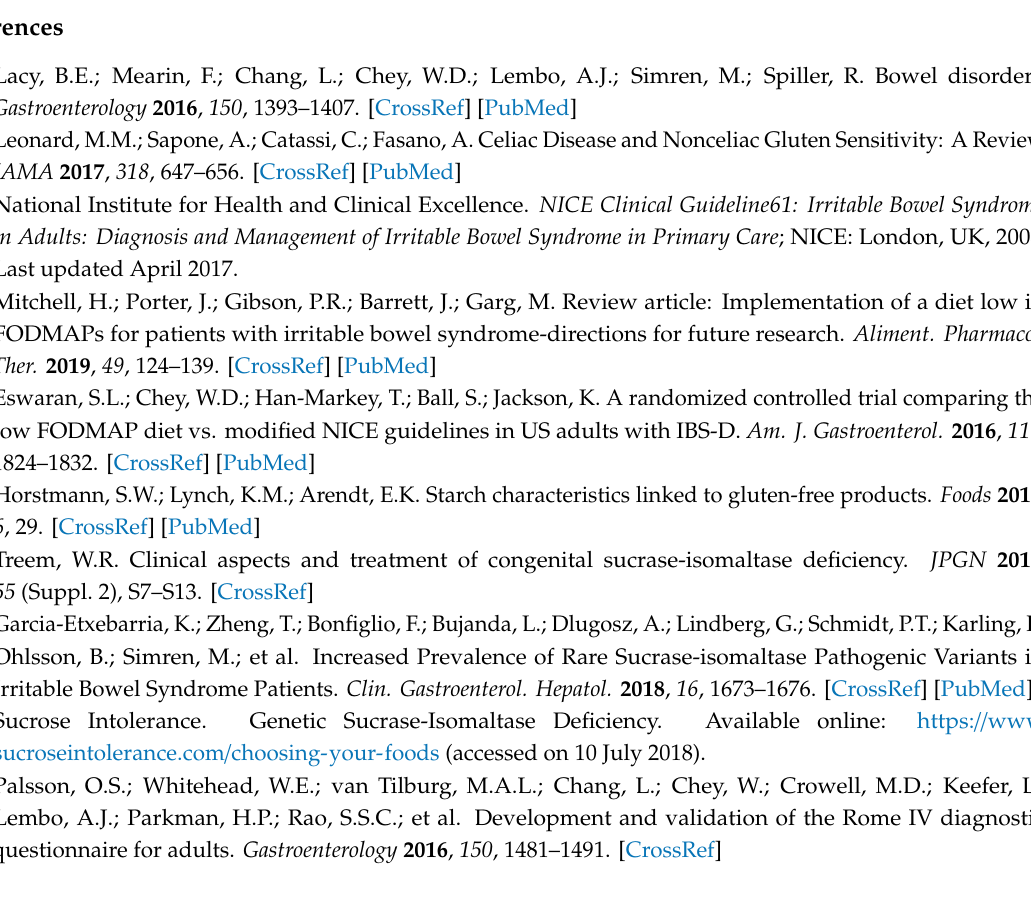
Table S1: Reasons for not being eligible for / declining study participation, Table S2: Recommendations of fruit intake according to a starch- and sucrose- reduced diet, Table S3: Recommendations of vegetable and legume intake according to a starch- and sucrose-reduced diet, Table S4. Concomitant diseases besides irritable bowel syndrome (IBS) and drugs used as regular treatments, Figure S1: CONSORT 2010 Flow Diagram, Figure S2: Flow chart over inclusion and exclusion